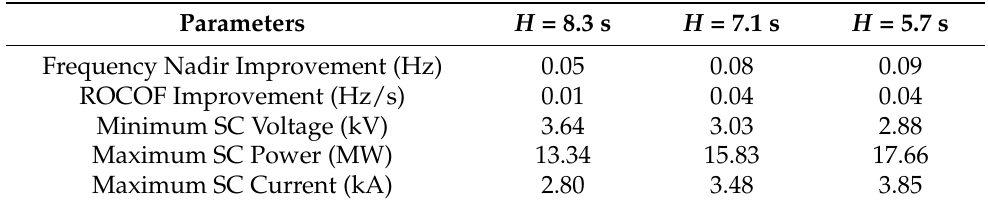
Figure 10. FFR provision from the converter-connected SC in systems with different inertia constants: (from top to bottom: system frequency (solid lines—cases with control, dash lines—cases without control), SC terminal DC voltage, SC output DC power, SC output DC current). Table 2. Overview of simulation results of FFR provision from the converter-connected SC in systems with different inertia